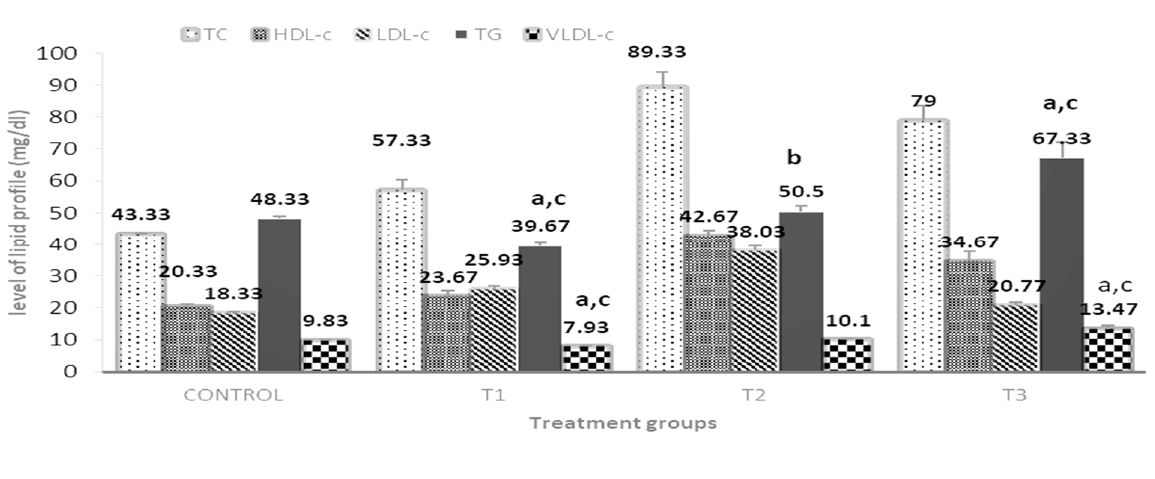
Figure 8. Effect of pomegranate peel and garlic powder separately or in combination on serum lipid profile of does. Values are presented as means ± SE (n = 5 litters). TC; The total cholesterol, TG; triglyceride, HDL-c; low-density lipoprotein, LDL-c; low-density lipoprotein, VLDL-c; very low-density lipoprotein. T1; pomegranate peel 3%, T2; garlic 3%, and T3; pomegranate peel 1.5% + garlic 1.5%. a Significant difference as compared to control, b Significant differences as compared to T1, and c significant differences as compared to T2 ( p < 0.05).